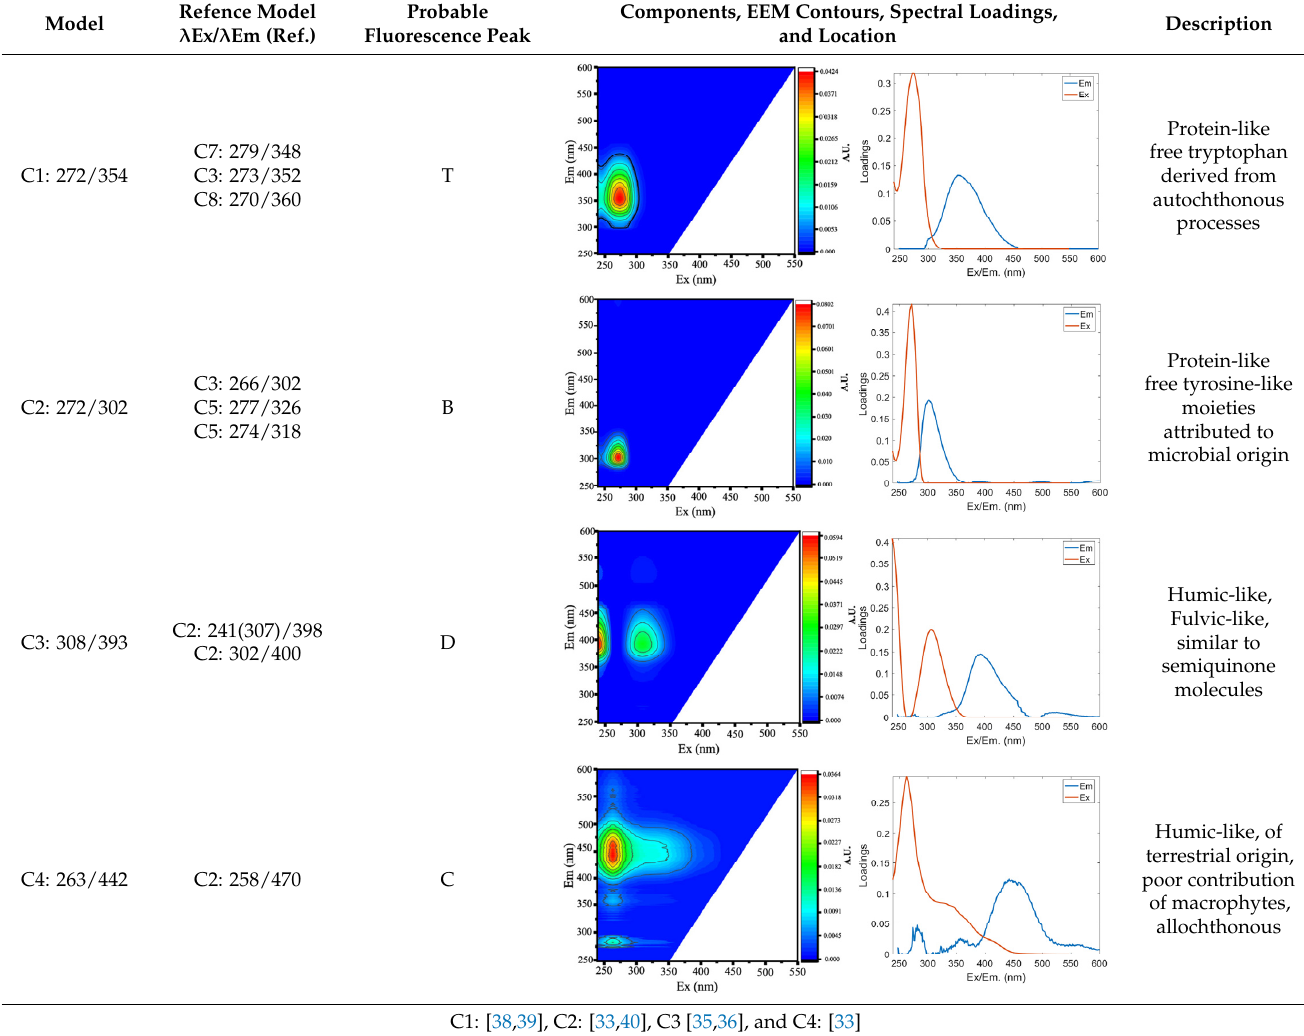
Table 1. EEM positions, EEMs contours, spectral loadings, and loadings of fluorescent components of AEs and LEs determined using the EEM-PARAFAC model and the corresponding fluorescence peaks.